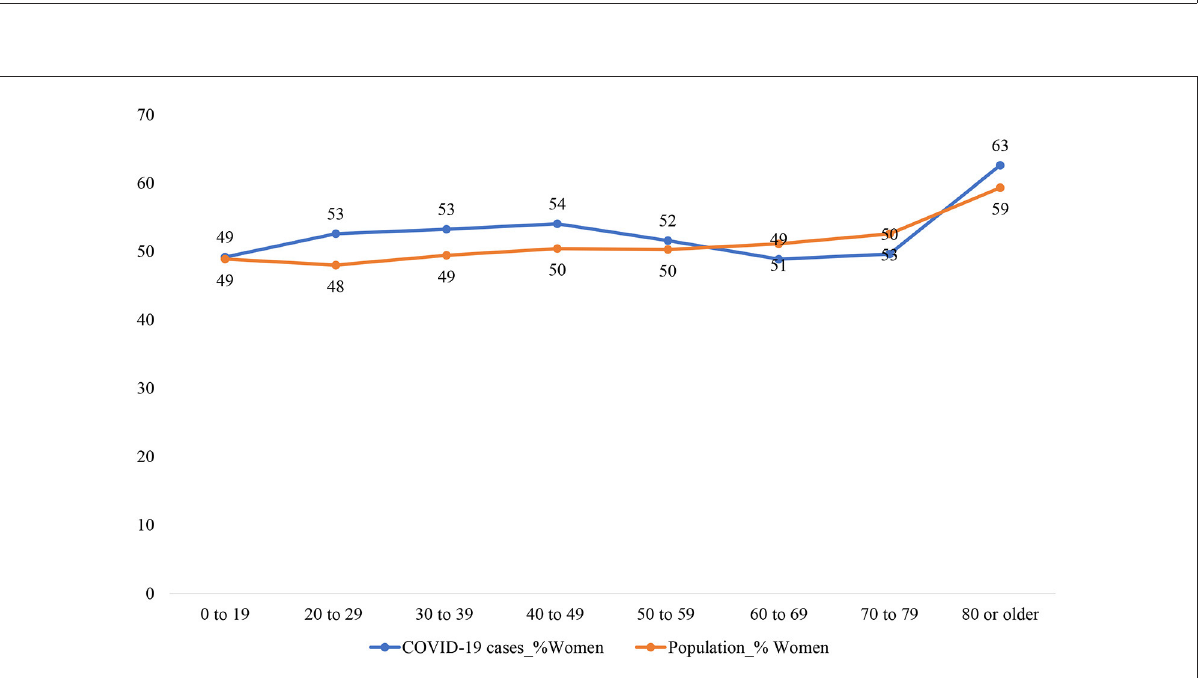
FIGURE2 Comparing the share of women among COVID-19 cases and among the general population. The share of women among the general population is estimated using data from Statistics Canada (2021): doi: